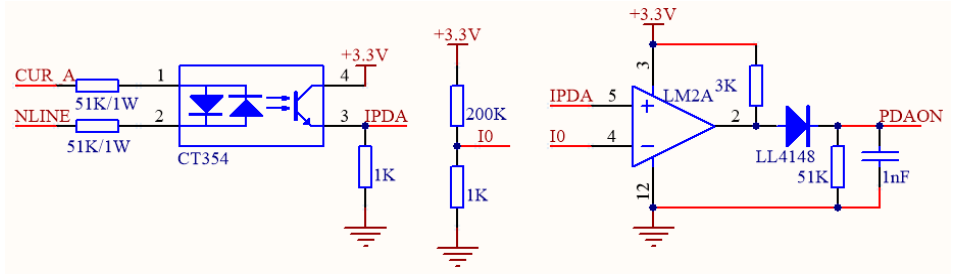
Figure 7. Action time acquisition circuit.